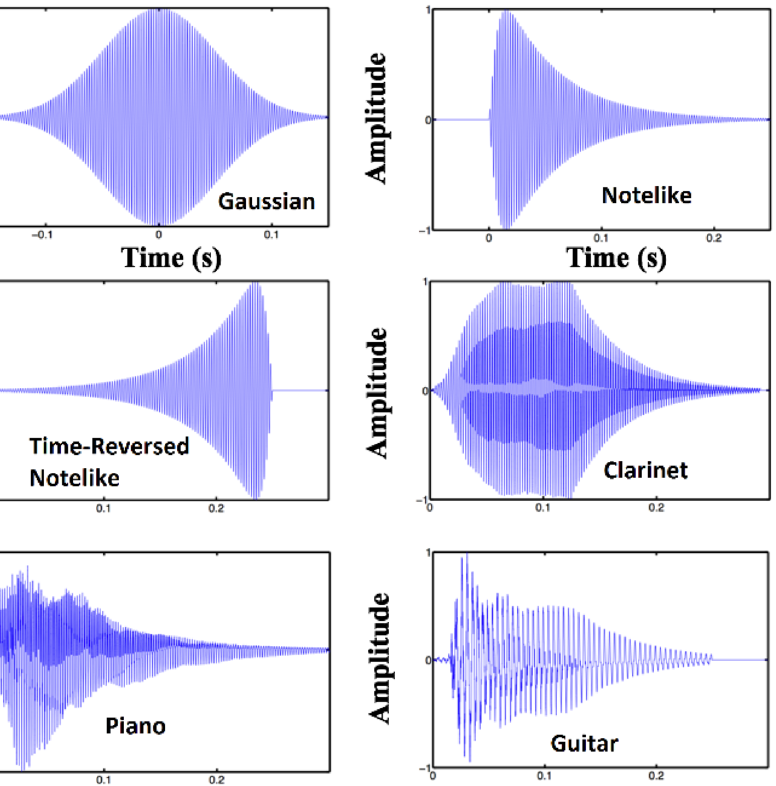
Figure 1. Wavepackets used in experiments and musical notes, at 440 Hz. Musical notes are shown for comparison with our test stimuli as well as to demonstrate the waveforms of certain types of natural sounds. Note that each of the musical notes is time-reversal symmetry broken.